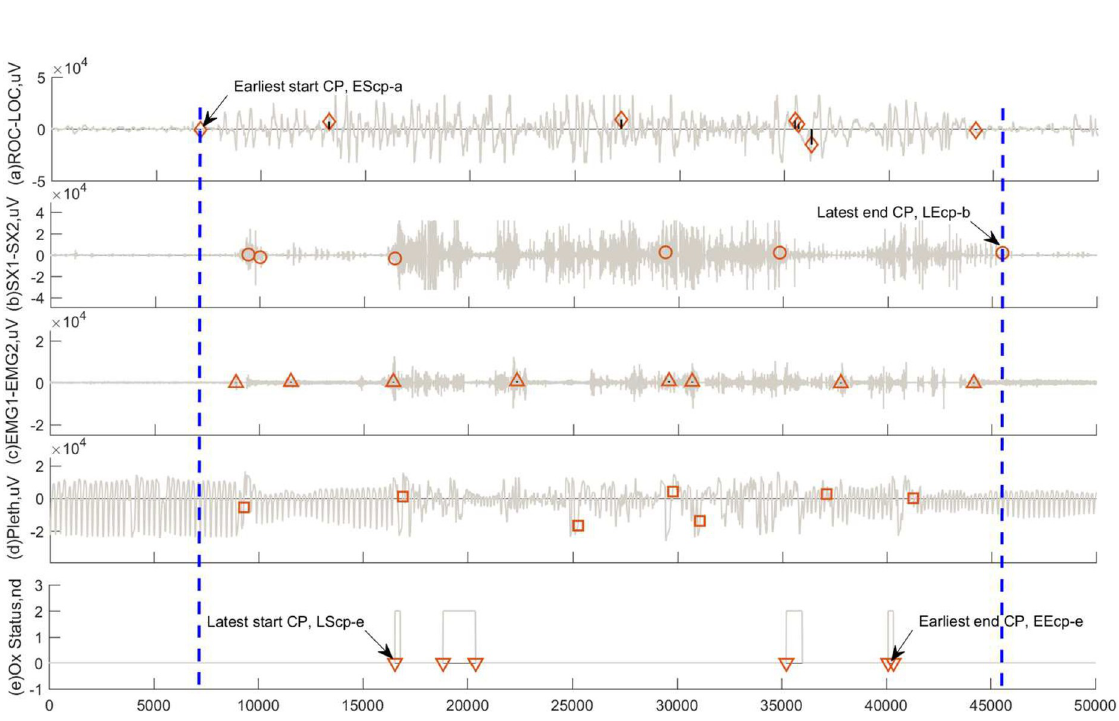
Fig 12. The results of MCPs detection by using our RSW&TST framework on five pathological signals in the nfle10m recordings of a patient diagnosed with NFLE in the CAP sleep database. During an identical period of NFLE sudden attack, the resultant MCPs are detected from two EEG signals (a) ROC-LOC, and (b) SX1-SX2, as well as other three signals (c) EMG1-EMG2, (d) Pleth, and (e) Ox Status, respectively.